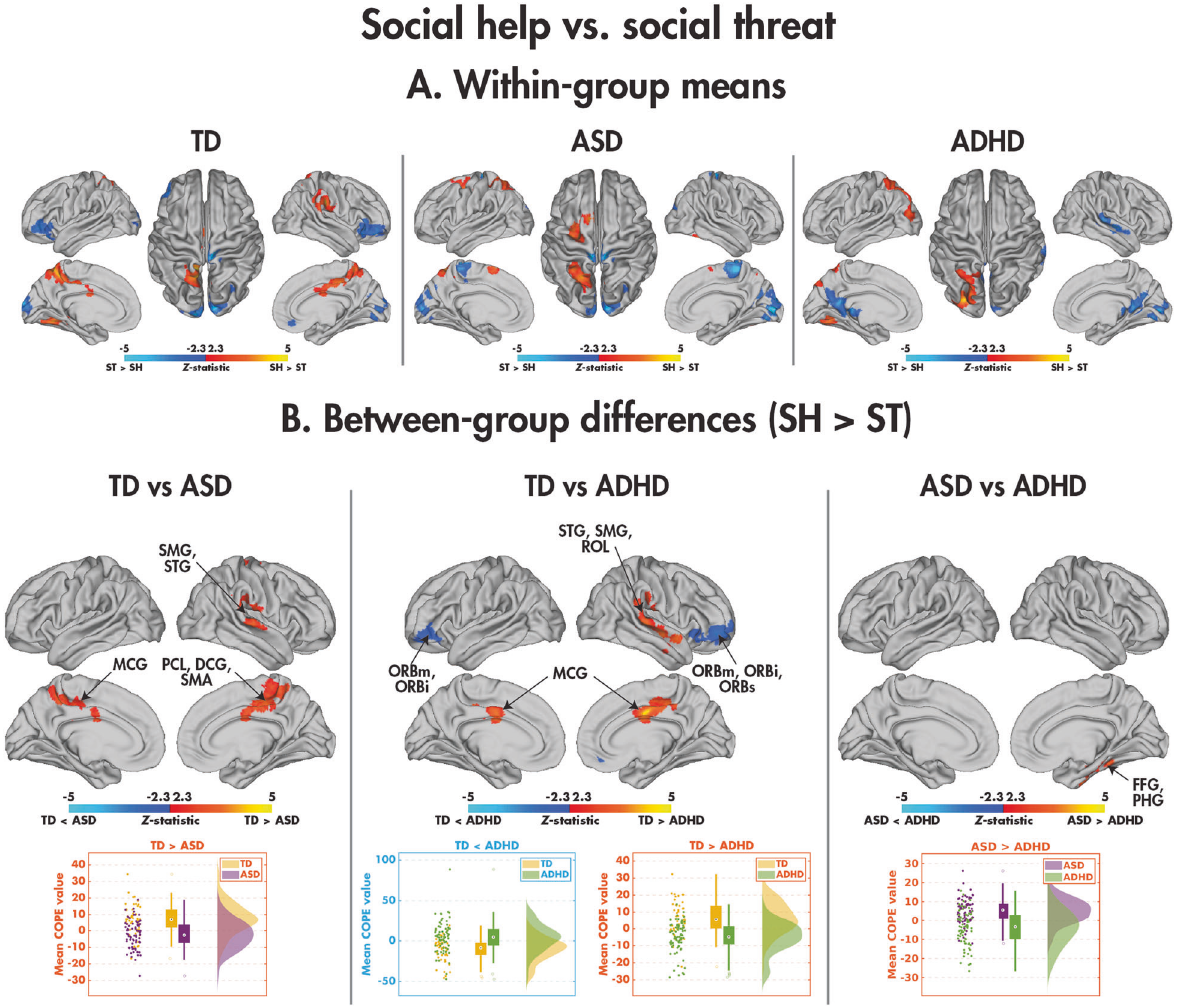
Fig. 4 Comparing the social help and social threat conditions in the SAT. Signi fi cant ( p corr < 0.05) within-group effects are shown for the TD, ASD, and ADHD participants ( A ), and signi fi cant ( p corr < 0.05) between-group effects are shown for the TD vs. ASD, TD vs. ADHD, and ASD vs. ADHD participants ( B ).